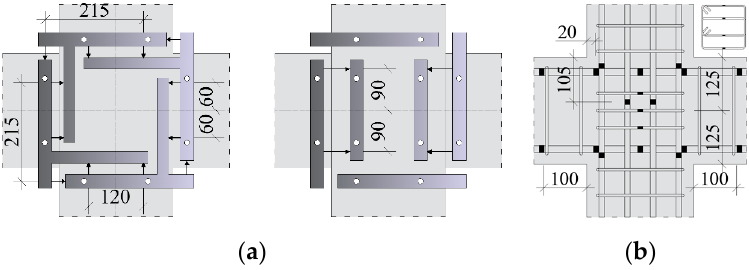
Figure 6. ( a ) Measurement system for the joint deformation and fixed end rotation; ( b ) strain-gauge locations (unit in mm).